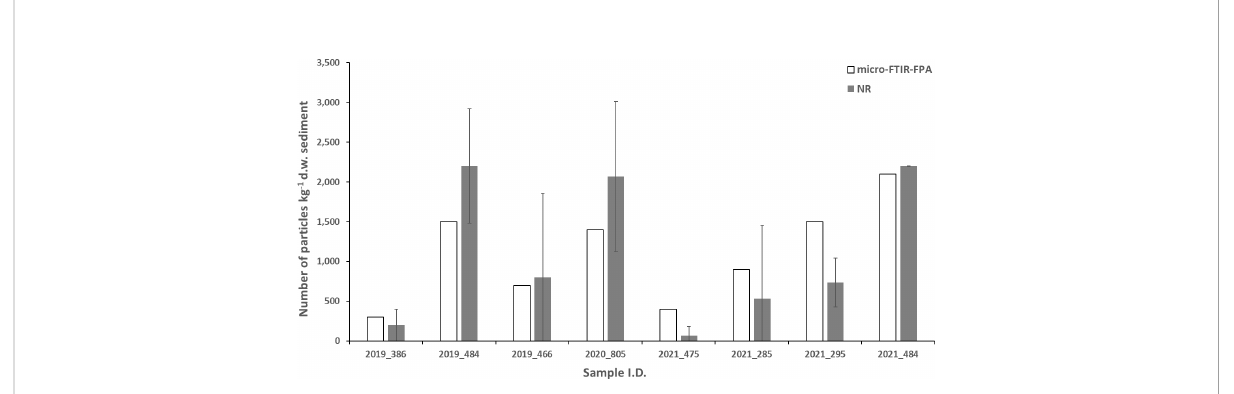
FIGURE 9 Microplastics analysis from micro-FTIR-FPA and comparison to NR output for some selected sampling sites